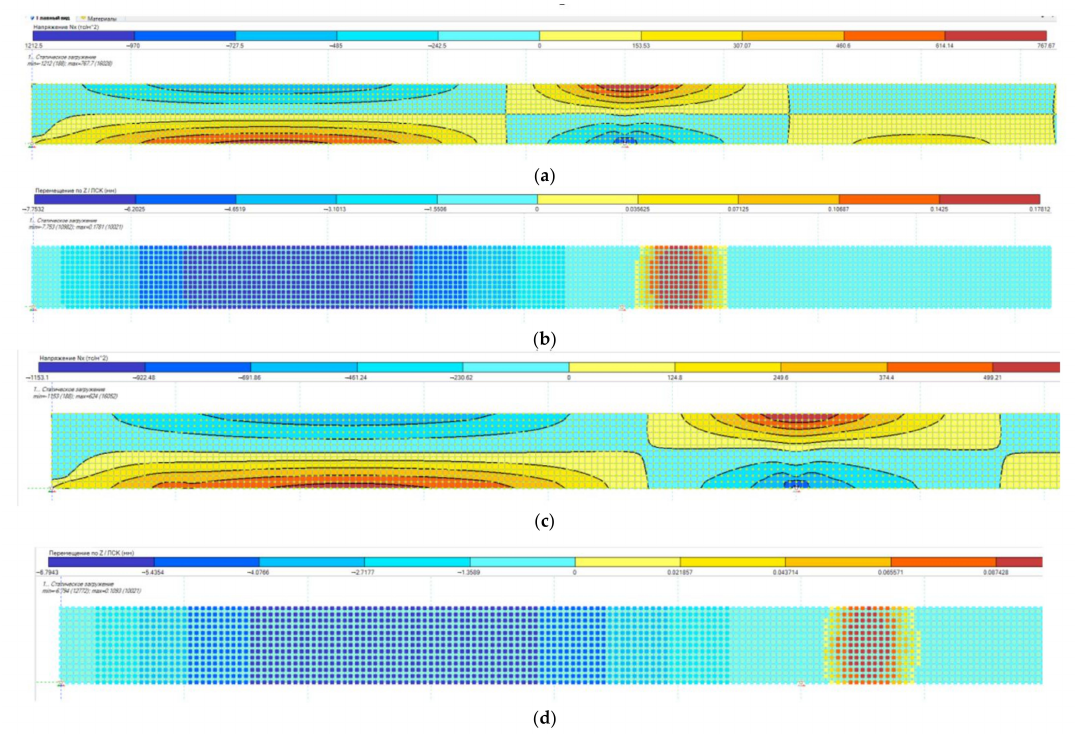
Figure 5. The isofields of the distribution of stresses and displacements for the half of the beam: ( a ) isofields of normal stresses σ x , MPa for a glued beam (half-length); ( b ) vertical displacements z, mm for a glued beam (half-length); ( c ) isofields of normal stresses σ x , MPa for a composite beam (half-length); ( d ) vertical displacements z, mm for composite beam